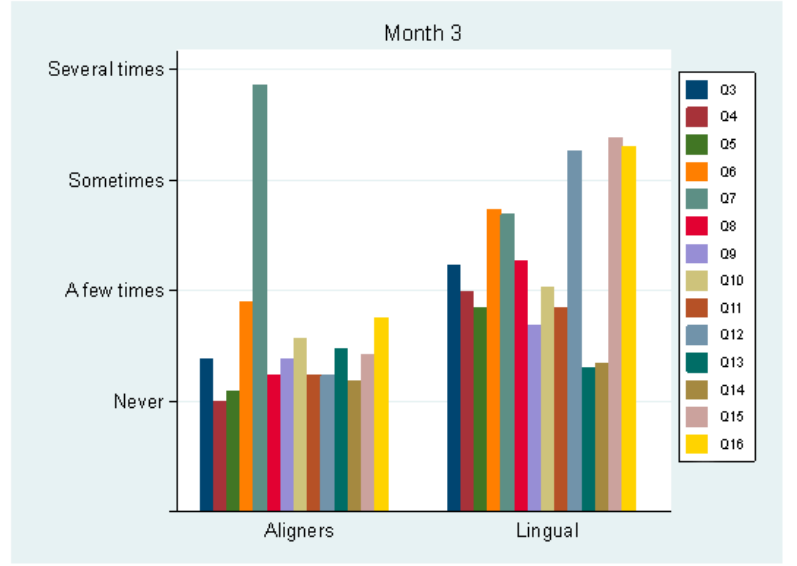
Figure 2. Average values of answers to questions 3–16 by group, after 3 months. The predicted values of pain perception and total score for Q3–16 (transformed to a 0–100 scale, 0, best score; 100, worst score) were estimated from a model including group effects, time effects and their interaction.